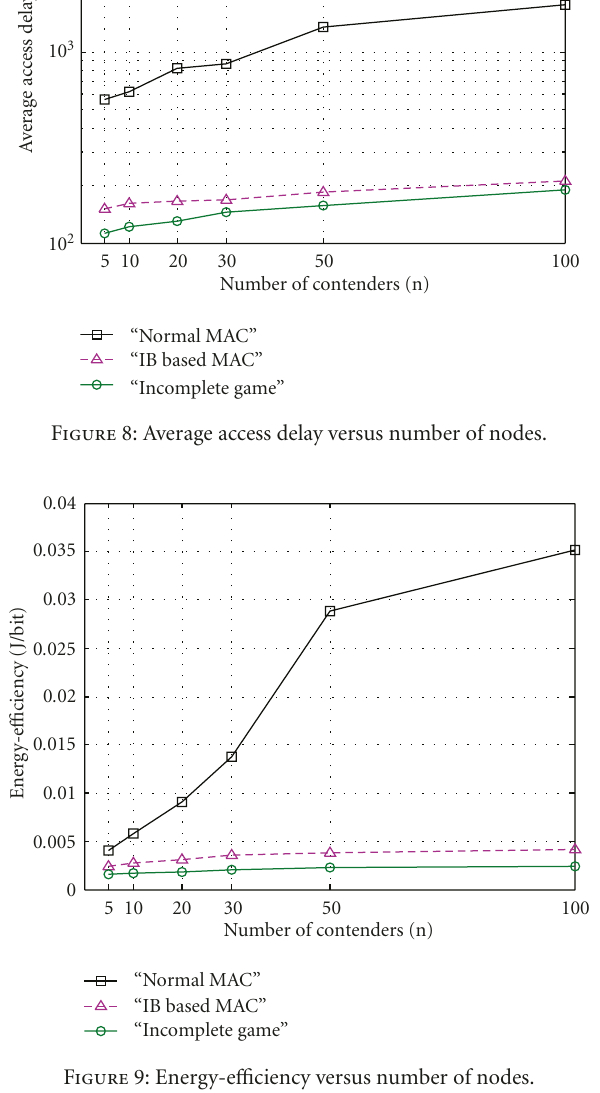
most of the nodes choose higher contention slots while very few nodes selects lower contention slots, hence less or no collision and low waiting time in backo ff procedure. For “Incomplete Game” channel e ffi ciency almost keep constant after 30 nodes, as each node can adapt to the variable game state and choose corresponding equilibrium